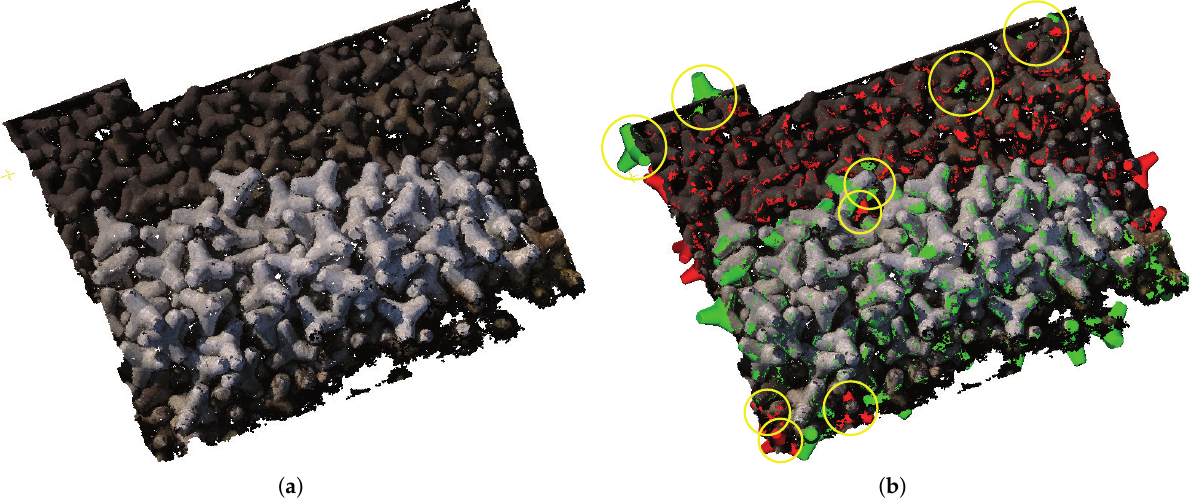
Figure 18. Visualization of results of block-type classification on Todohokke port. ( a ) is the real point cloud scene of Todohokke port measured by UAV, and ( b ) is the result of type classification after instances segmentation and pose estimation. Block B1 and Block B2 are rendered in red and green, respectively. The yellow circles indicate misclassified blocks.